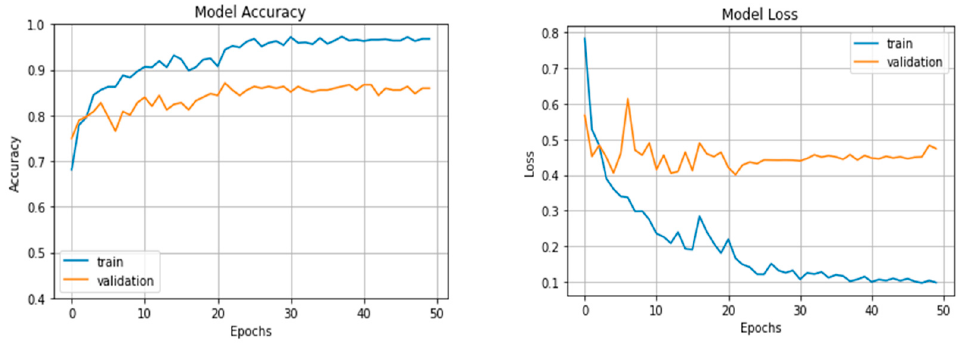
Figure 13. Accuracy and categorical cross-entropy over the epochs.